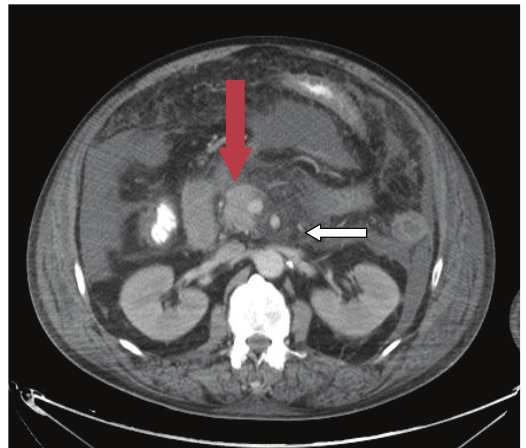
a partially loculated fluid within the body of the pancreas. The white arrow shows an area of focal necrosis within the body of the